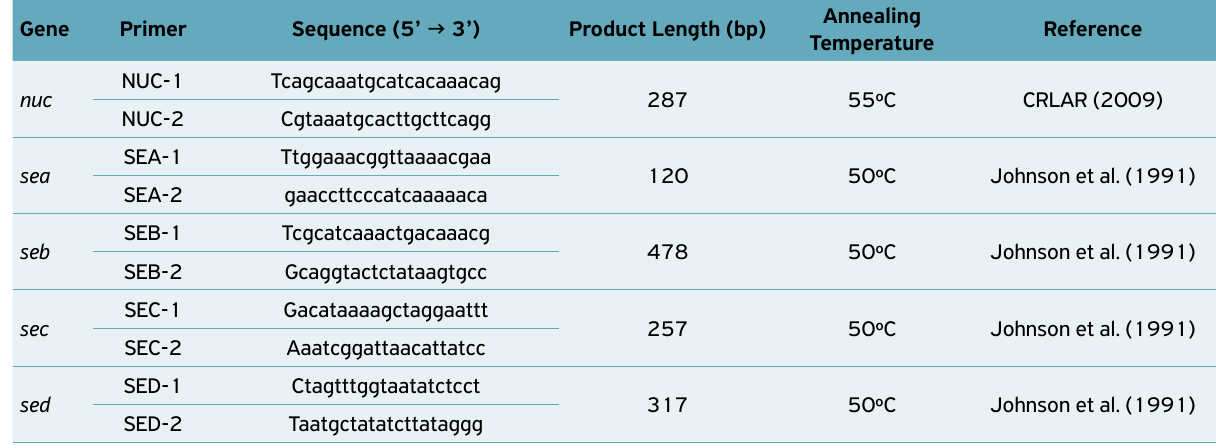
Table 1. Characteristics of the primers used in this study for Staphylococcus aureus comprovation and detection of enterotoxins A, B, C and D